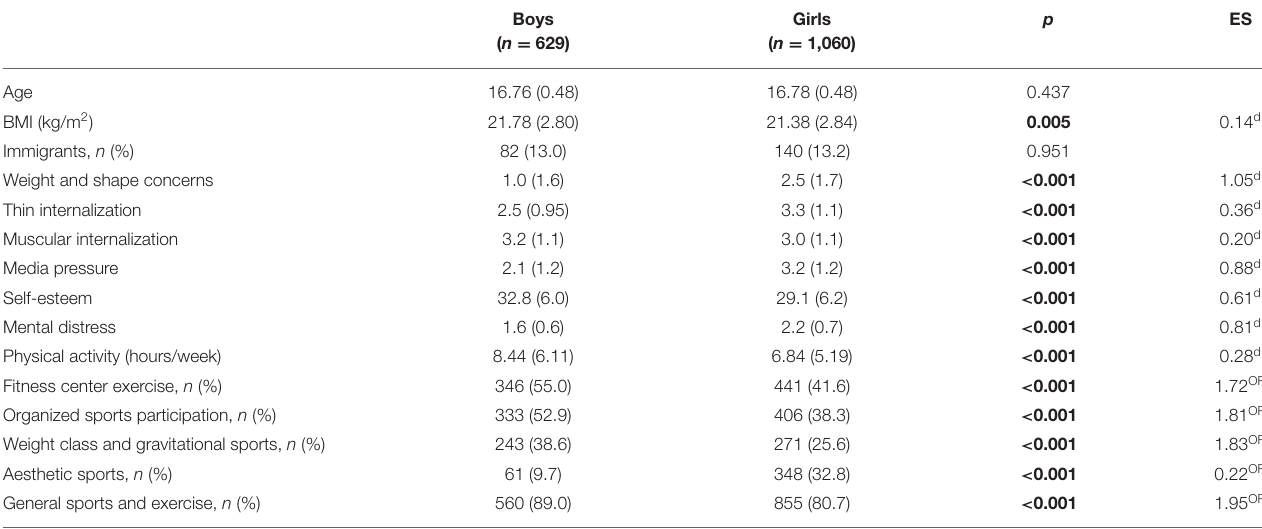
TABLE 1 | Descriptive characteristics for boys and girls presented as the mean (standard deviation) or number of observations (percentage) with Cohen’s d (d) or odds ratio (OR) as effect size (ES) for scale and dichotomous variables,